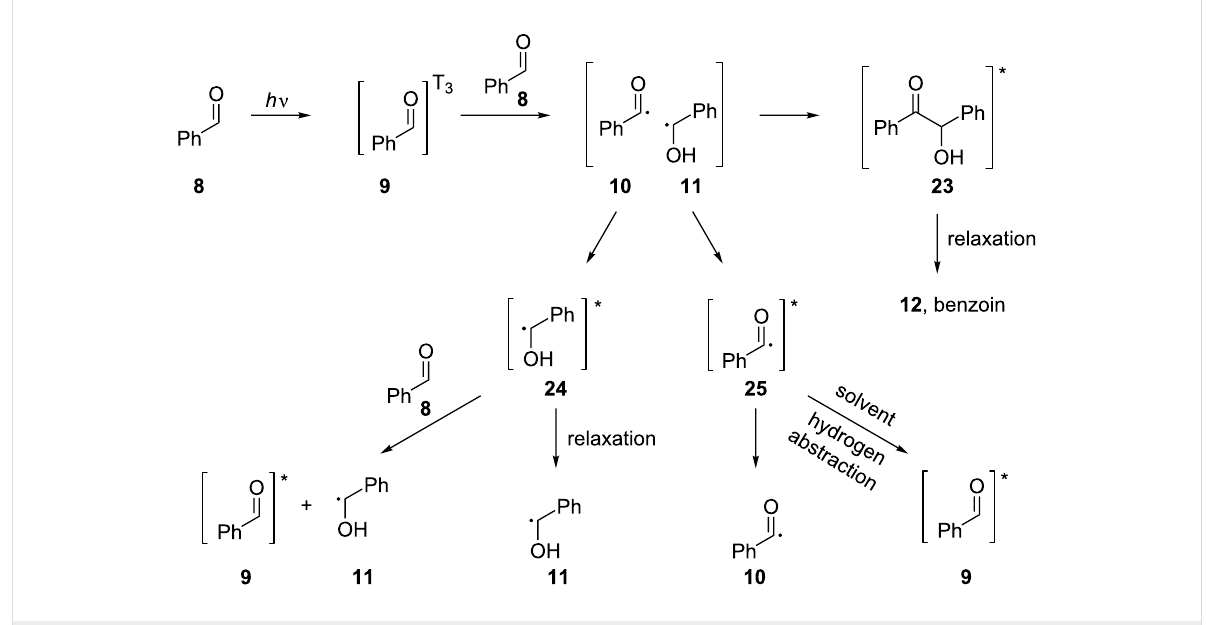
Scheme 6: Reactions that lead to polarized products detectable by CIDNP.